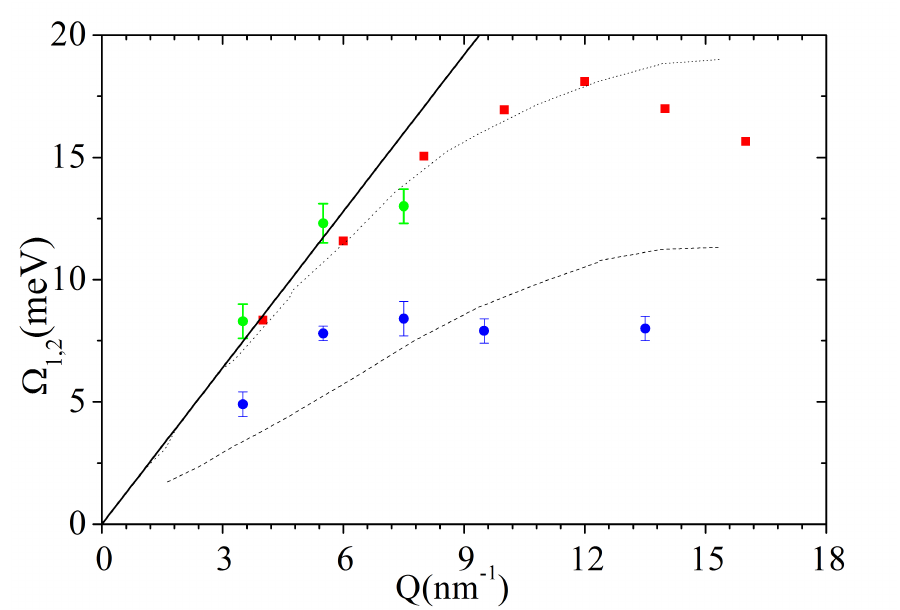
Figure 6. The dispersion curves of the high ( Ω 2 ) and low ( Ω 1 ) frequency inelastic modes of the Au NP suspension in water are reported as green and blue dots, respectively, as determined from the best fit provided by the RJ-MCMC Bayesian inference method described in the text. In addition, the acoustic phonon branches measured in crystal along the Au [100] direction (dash and dots black lines) and the sound dispersion of liquid Au corresponding to the k =1 hypothesis are shown as estimated in Ref. [12] (red squares). The plot also includes, as a solid line, the linear hydrodynamic dispersion obtained with the ambient T sound velocity (3240 m/s). Adapted with permission from Ref. [19]. Copyright (2018) American Chemical